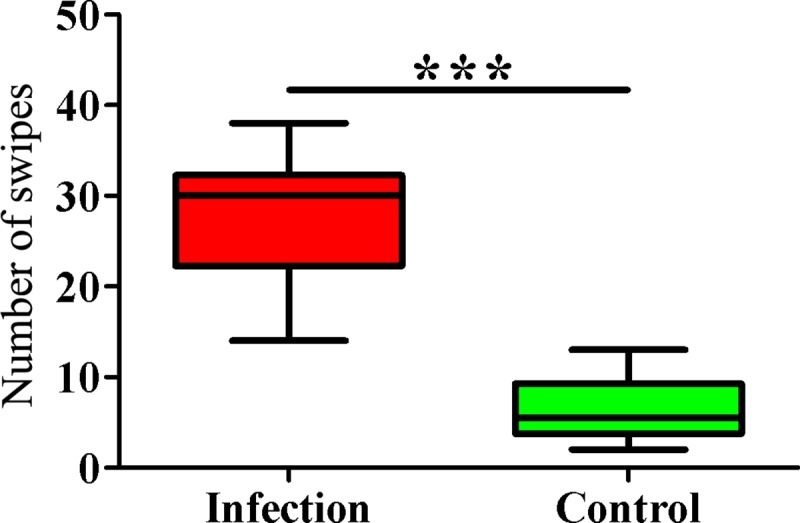
Behavioral observation results.*** indicates p < 0.001.